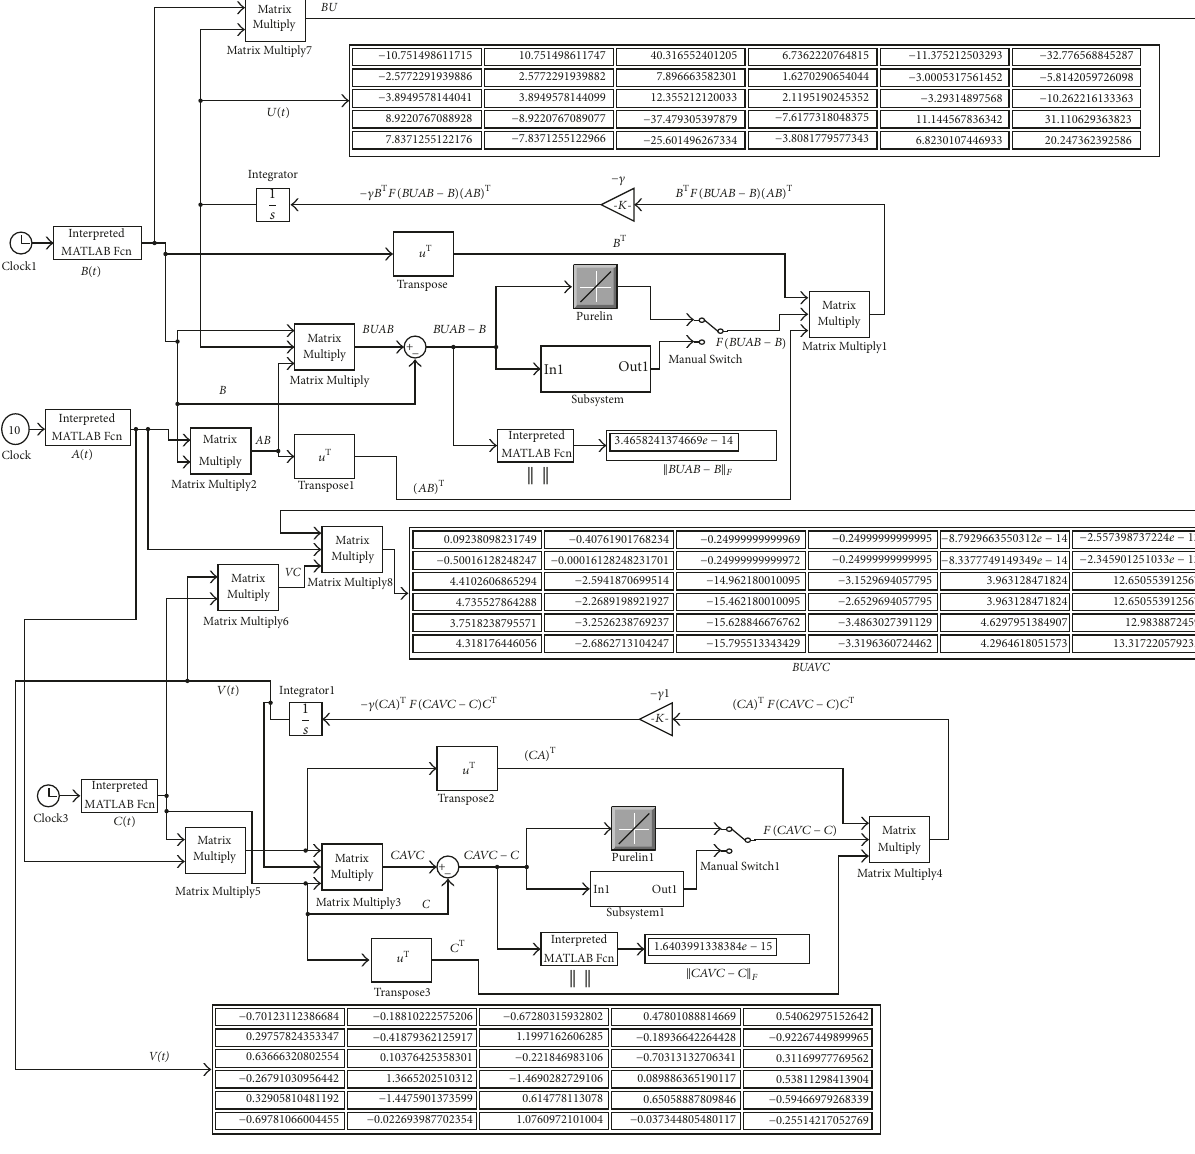
Figure 8: Simulink implementation of Algorithm